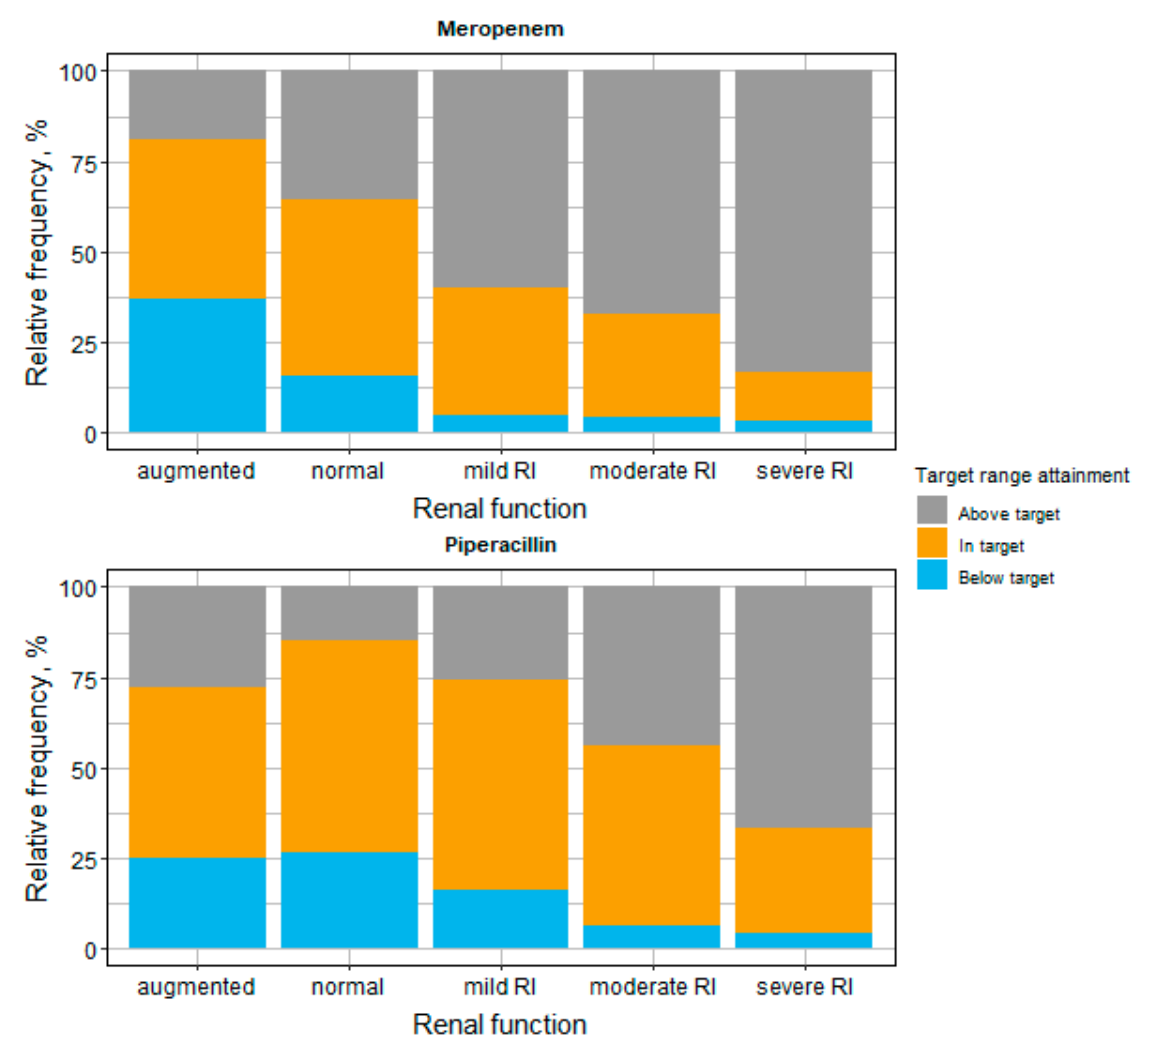
Figure 2. Target range attainment for meropenem and piperacillin stratified by renal function. Target range for the minimum drug concentration defined as 1–5 × MIC. If no MIC values could be determined, an empirical target of 8–40 mg/L and 16–80 mg/L was used for meropenem and piperacillin/tazobactam, respectively. Abbreviations: MIC: minimum inhibitory concentration; RI: Renal impairment. Table 3. Overview of observed adaptations in the dosing regimen for meropenem and